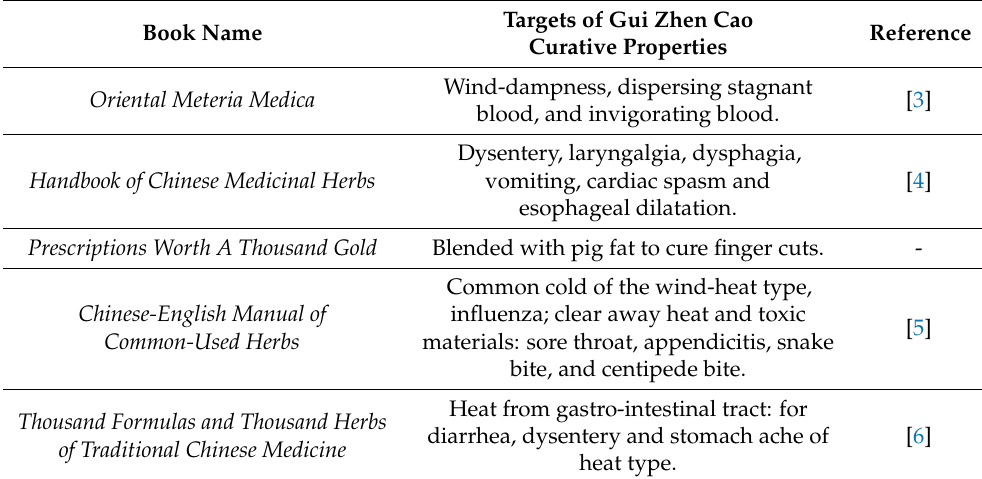
Table 1. Evidence of Gui Zhen Cao medicinal potential In Chinese Traditional